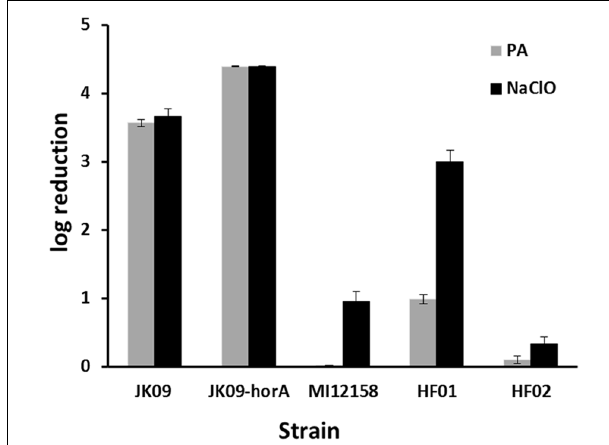
FIGURE 1 | Log reduction of five Lactobacillus brevis strains after exposure to 0.0014% peracetic acid (PAA; gray bars) and 0.0021% NaClO (black bars). The smaller the log reduction, the bigger the tolerance.The error bars indicate the SD.